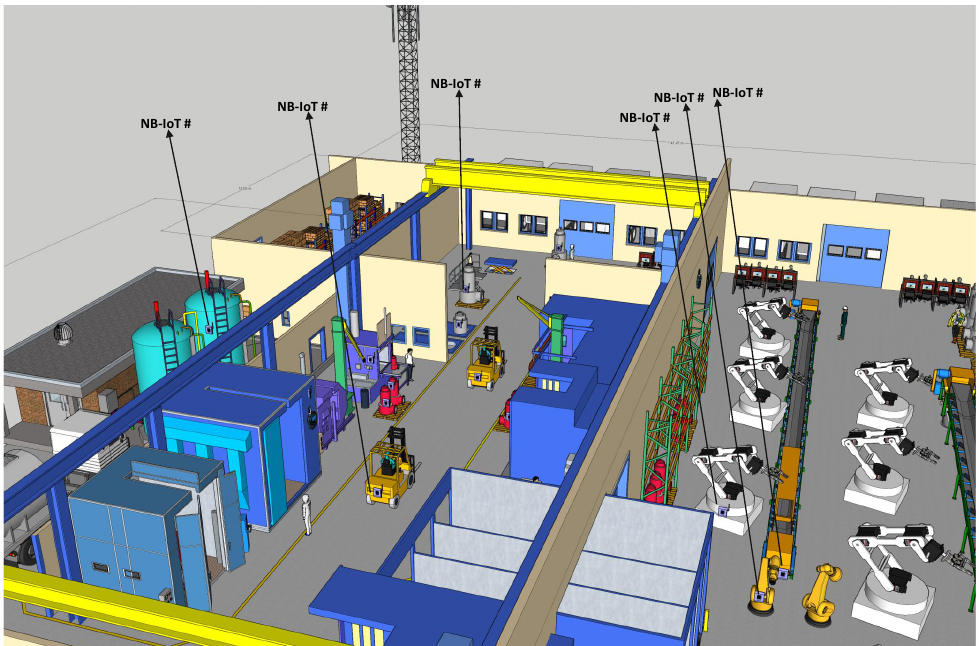
Figure 6. Diagram showing some of the positions of the NB-IoT terminals around the robotic arms, forklifts, and waste